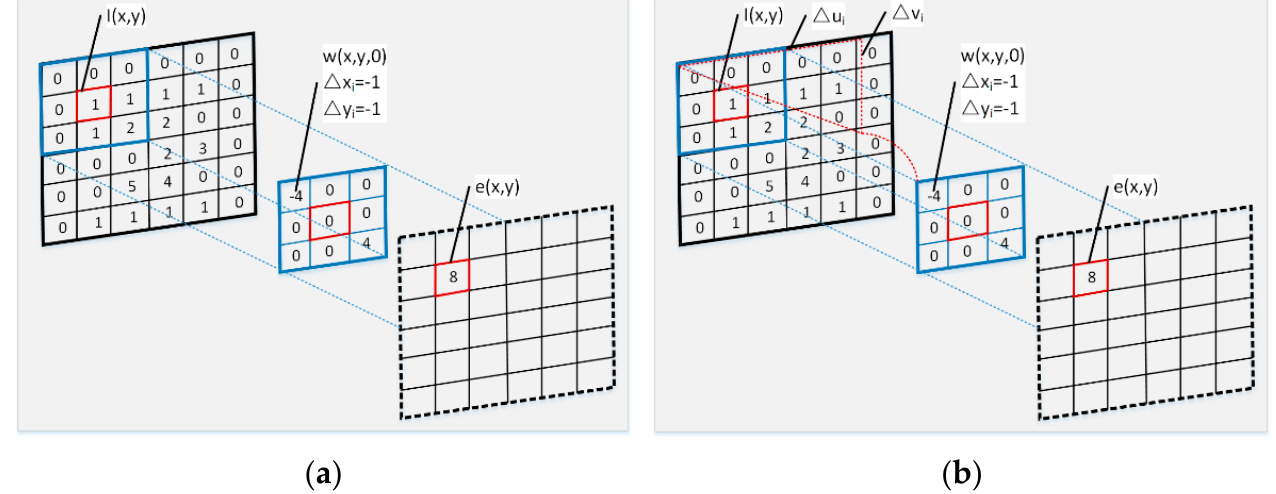
Figure 3. The filtering processes of a typical rectangular filter kernel and a deformable filter kernel: ( a ) rectangular filter kernel; ( b ) deformable filter kernel.